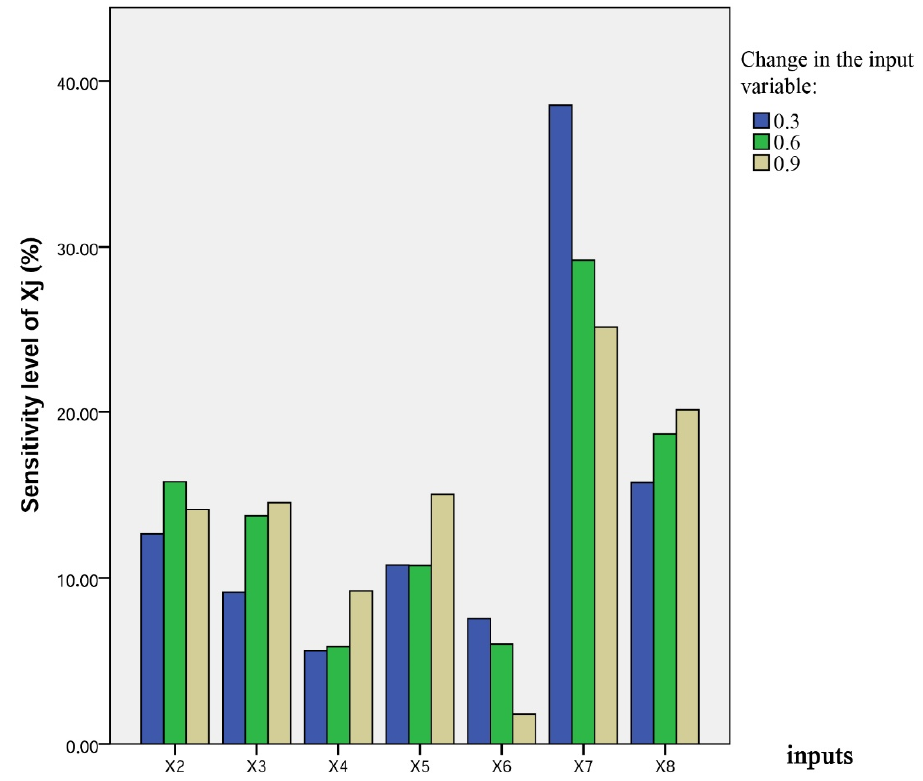
Figure 4. Results of the sensitivity analysis of the proposed model.